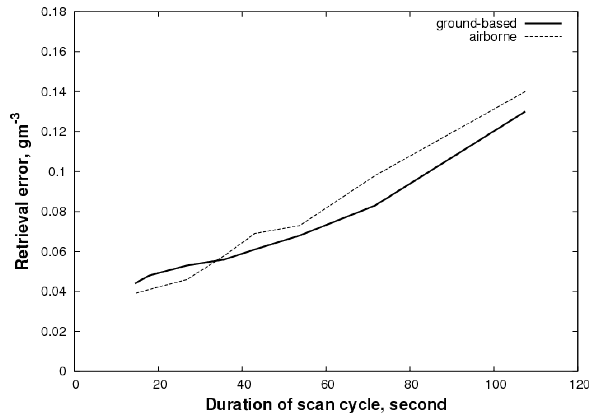
Figure 9. The retrieval error as a function of the duration of radiometer scan cycle (proportional to the inverse of radiometer scanning speed). For both the ground-based Fig. 9. The retrieval error as a function of the duration of radiome- and airborne setups, a faster radiometer results in more accurate tomographic retrievals. ter scan cycle (proportional to the inverse of radiometer scanning The stratocumulus cloud case is used for this sensitivity test. speed). For both the ground-based and airborne setups, a faster ra- diometer results in more accurate tomographic retrievals. The stra- tocumulus cloud case is used for this sensitivity test.